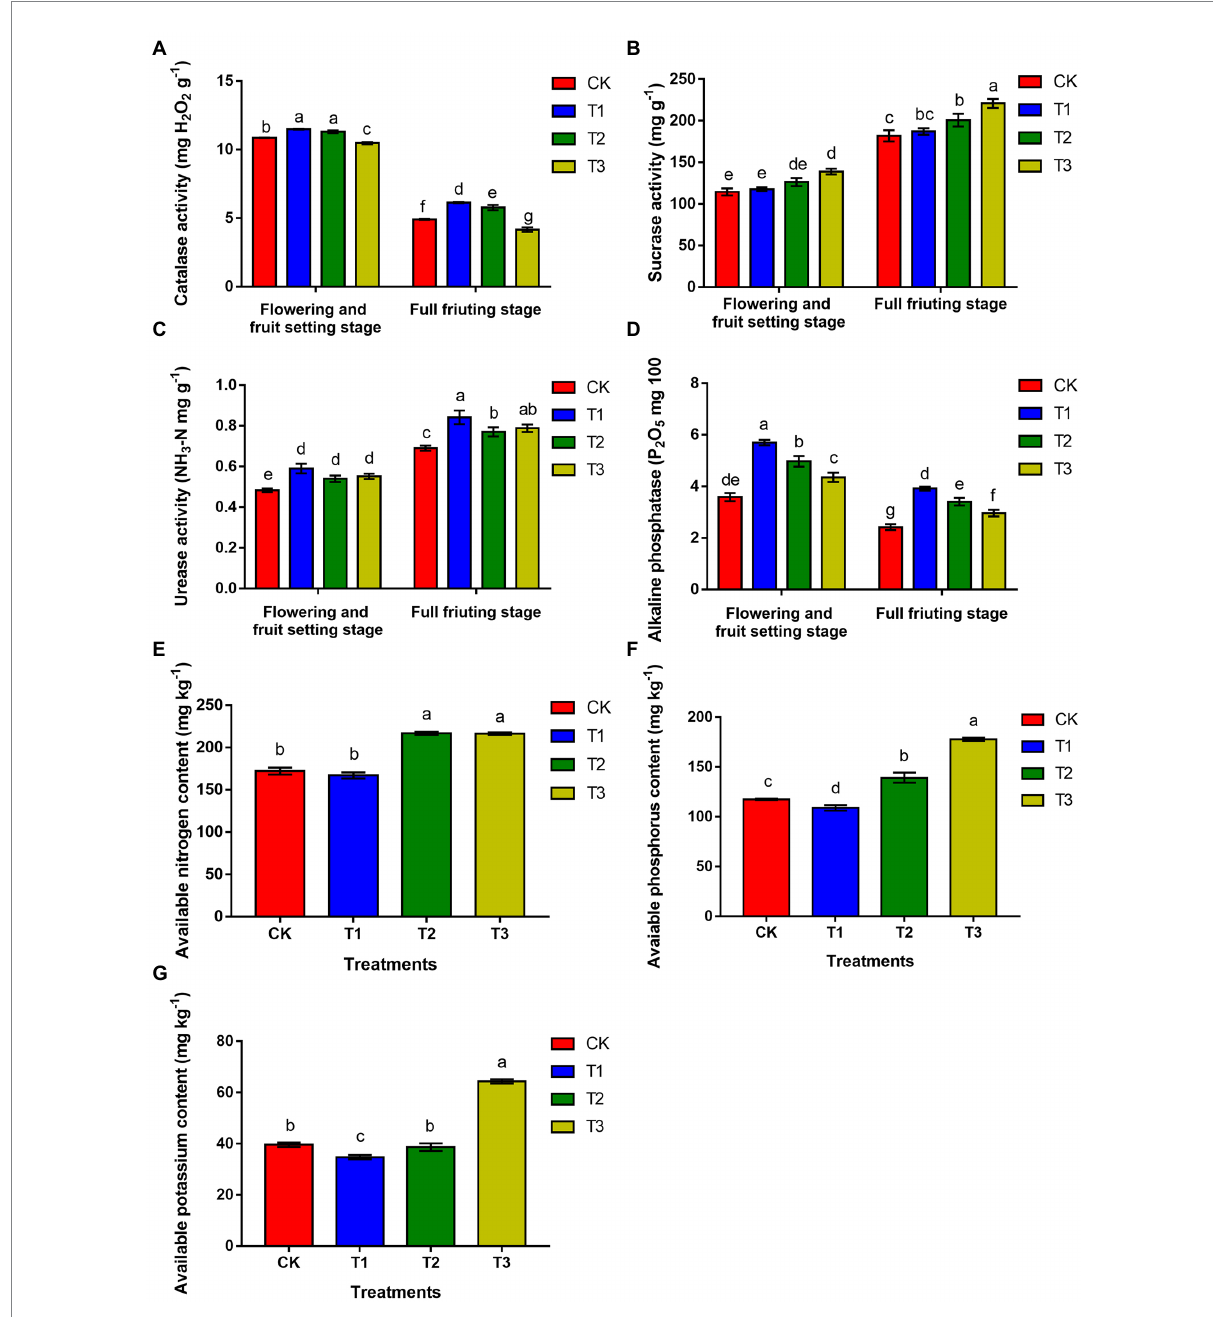
FIGURE 2 The effects of different irrigation amount on catalase activity (CAT; A ), sucrase activity (SA; B ), urease activity (UA; C ), alkaline phosphatase (APA; D ), available nitrogen content (E) , available phosphorus content (F) and available potassium content (G) . n ≥ 3; different letters indicate significant differences ( p <